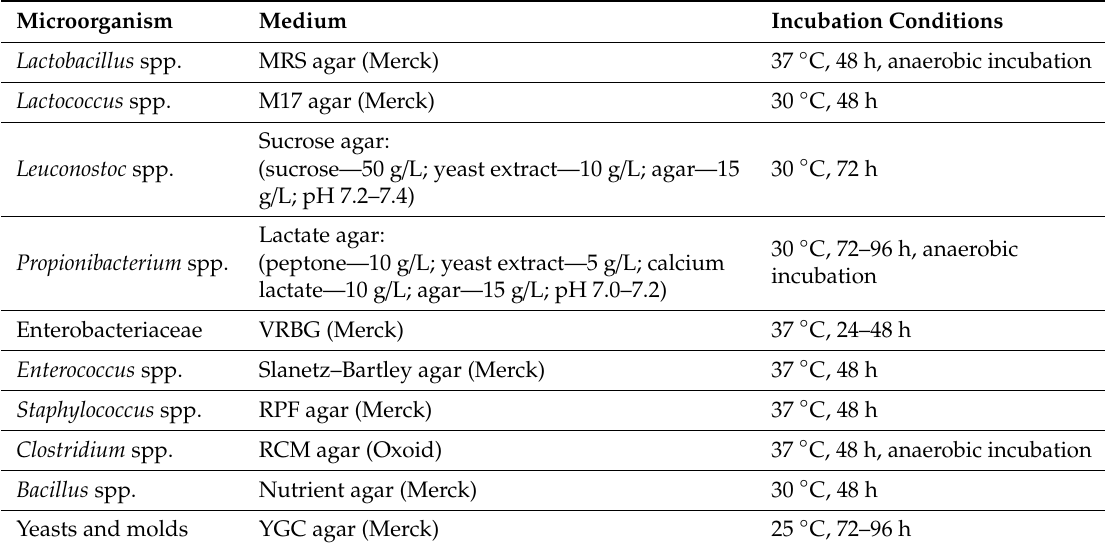
Table 1. Culture media and incubation conditions applied in the